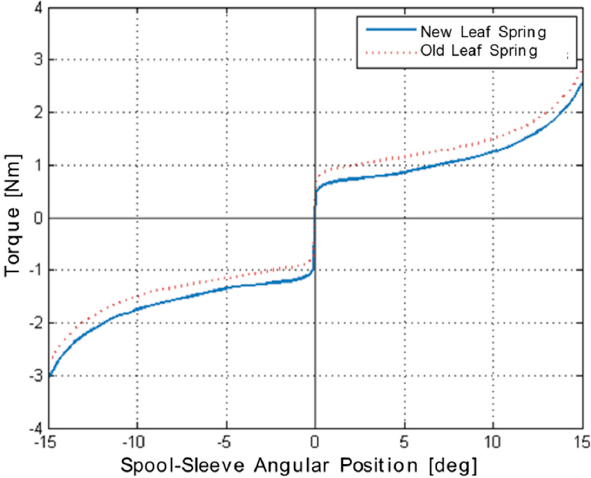
Figure 10. Original and modified leaf spring characteristic.